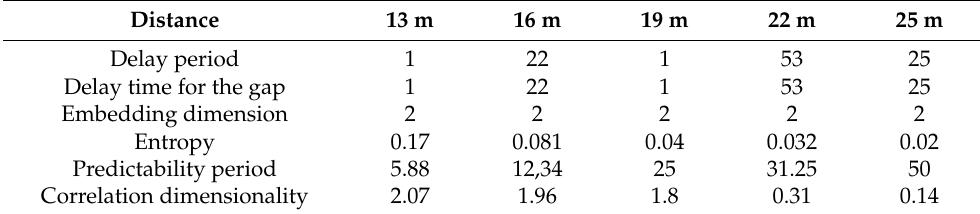
Table 3. Fractal